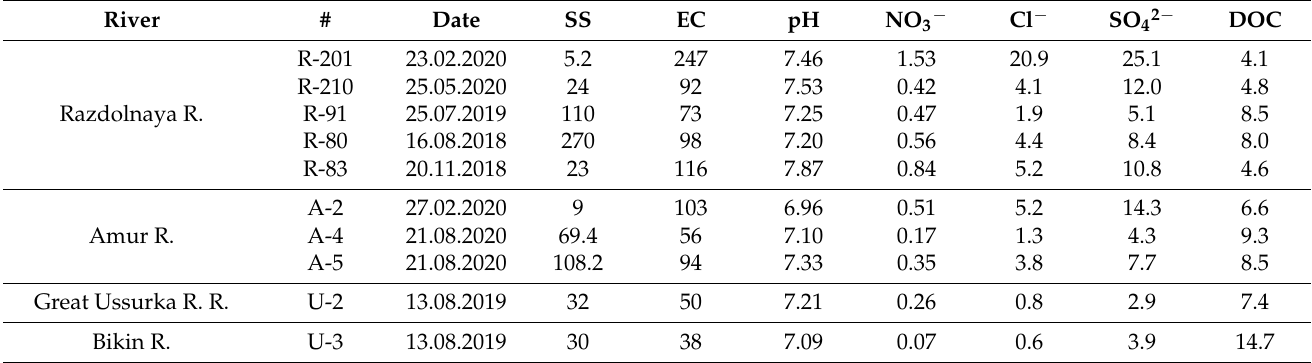
Table 1. Chemical composition of the boreal rivers studied within the Russian Far East 1 .